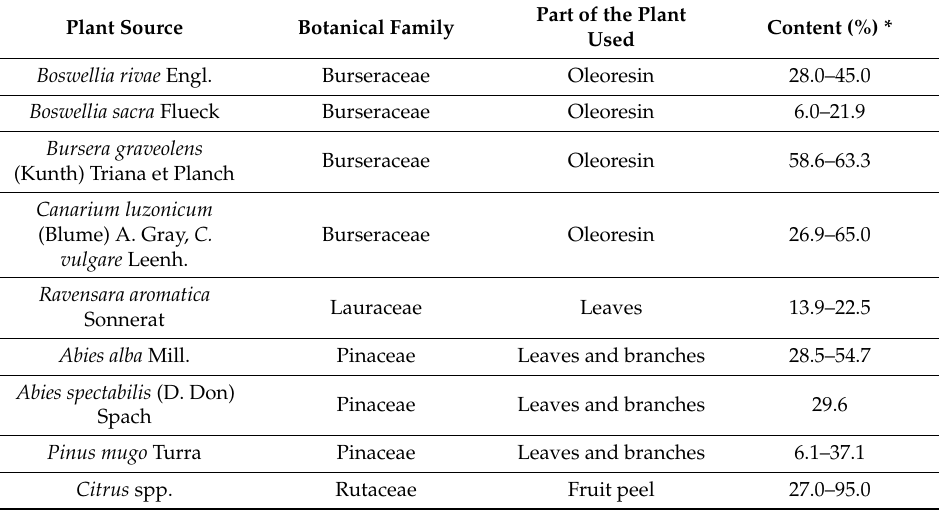
Table 3. Average content of D-limonene in some tree-derived essential oils